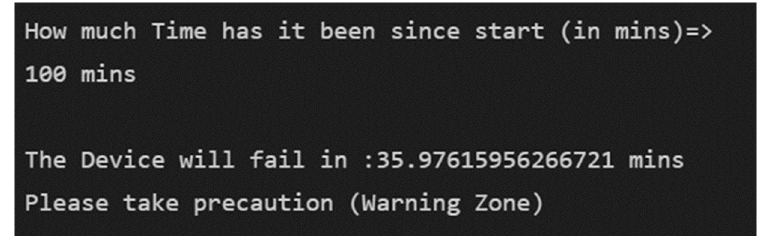
Figure 26. Framework tool output.